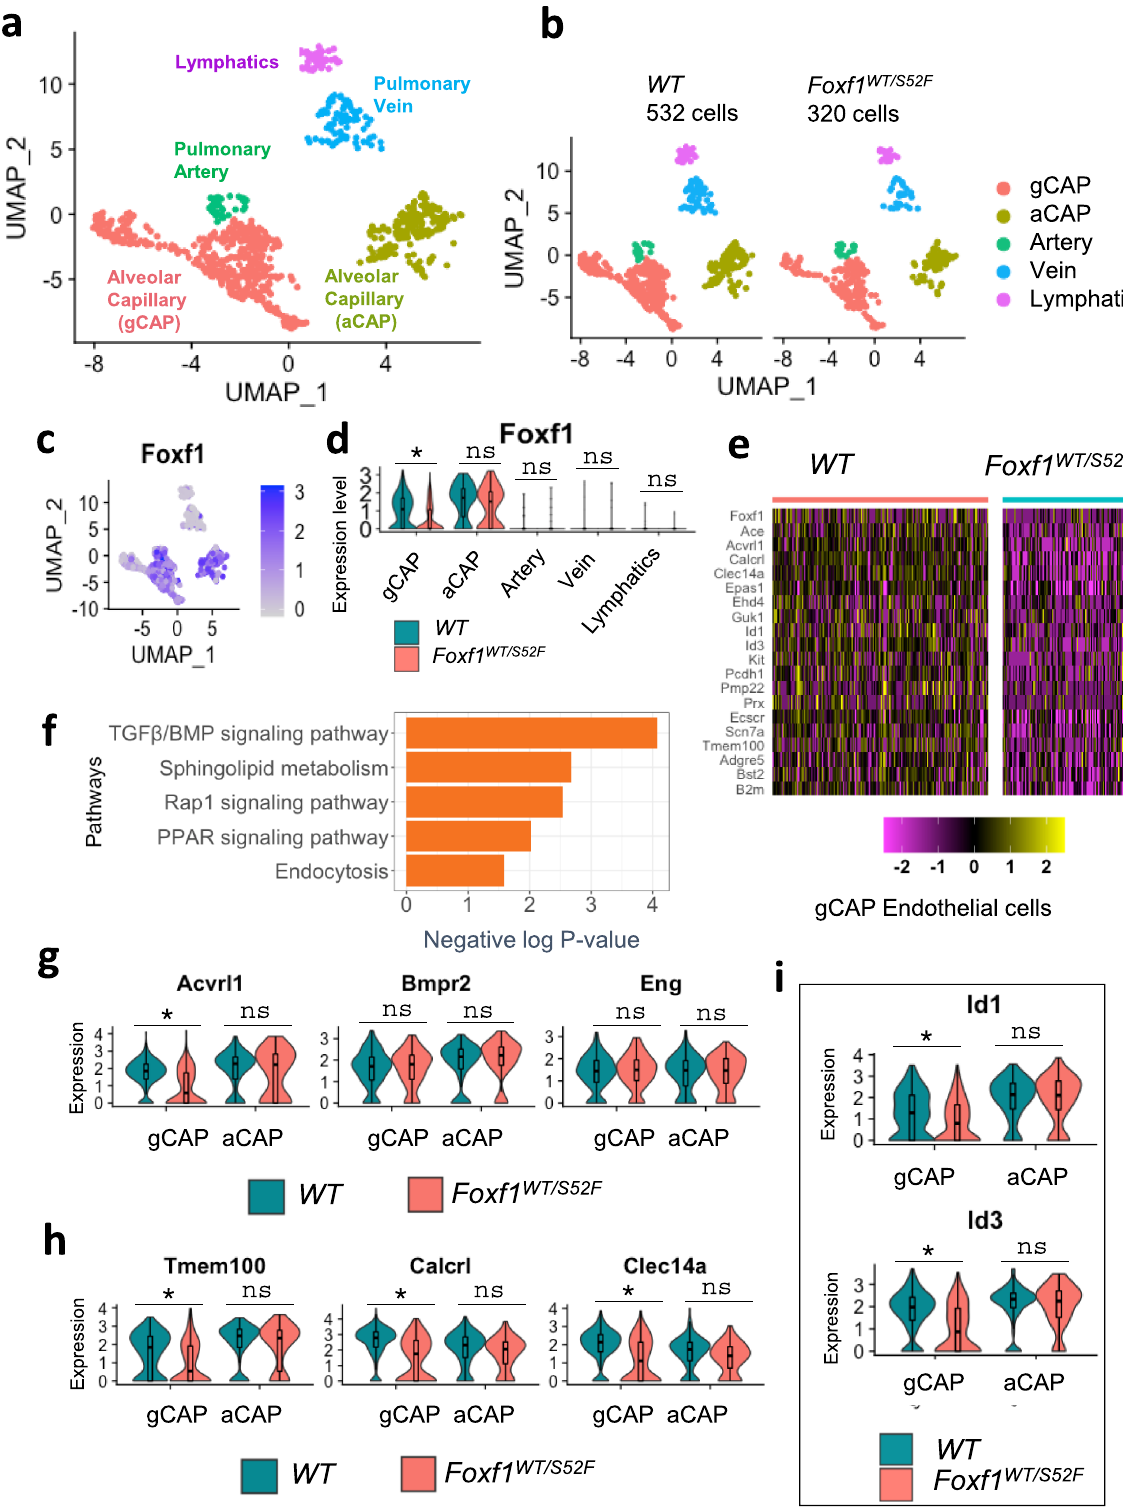
factors in addition to FOXF1. Comparative genomic analysis identi fi ed two conserved ETS binding sites near FOXF1 sites in the − 538/ − 458 bp Acvrl1 promoter region (Supplementary Fig. 13a, c). Based on scRNAseq data from WT E18.5 lungs, endothelial cells expressed several ETS transcription factors, including Fli1 , Erg and Ets1 (Fig. 6a). Fli1 mRNA was enriched in gCAPs compared to aCAPs (Fig. 6b). Both FOXF1 – and